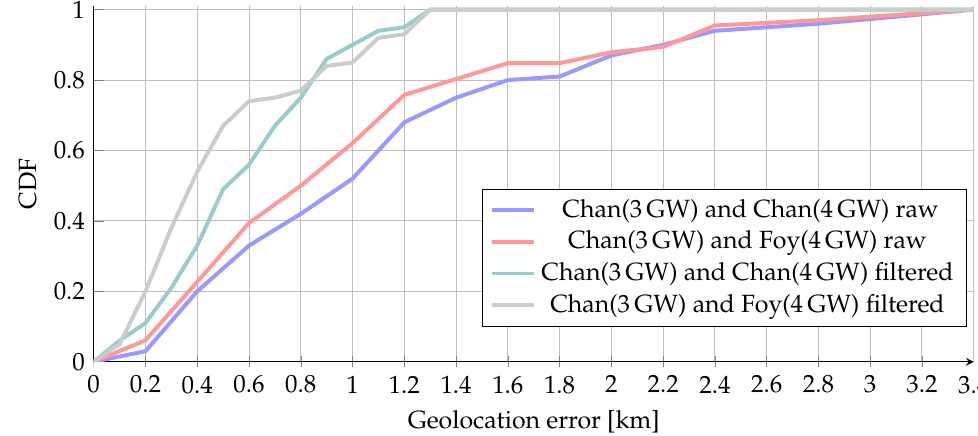
Figure 15. CDF of estimation results (3 and 4 GW) using combination of Chan’s and Foy’s algorithms before and after filtration.